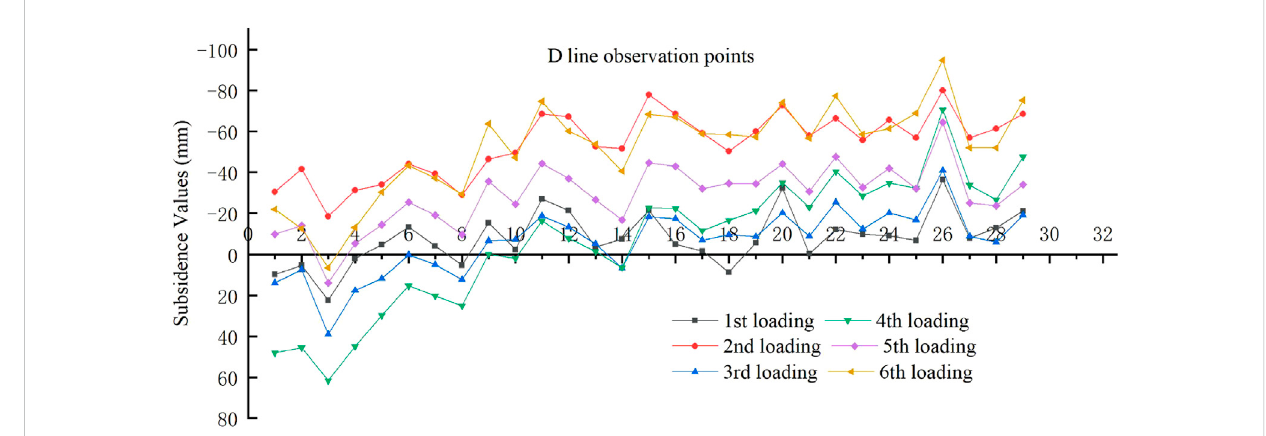
FIGURE 10 The change curve of subsidence value of measuring point in line H after loading.